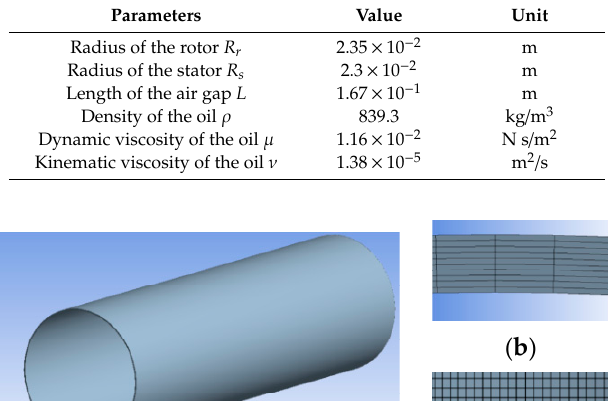
Figure 7. Comparison chart of theoretical results and CFD simulation results under laminar state and turbulent state.